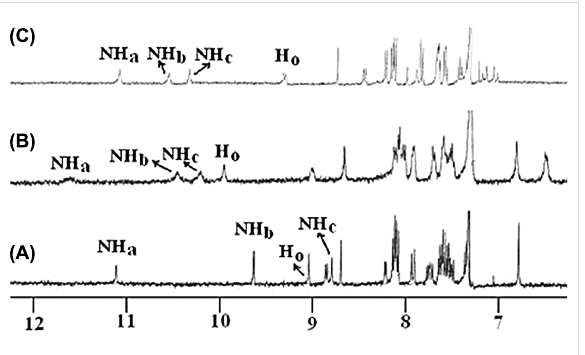
Figure 2: Change in 1 H NMR of (A) 1 (400 MHz, CDCl 3 containing 0.4% d 6 -DMSO; c = 2.80 × 10 − 3 M) and in the presence of equivalent amount of (B) L- N -acetylvaline, (C) L- N -acetylproline salts.